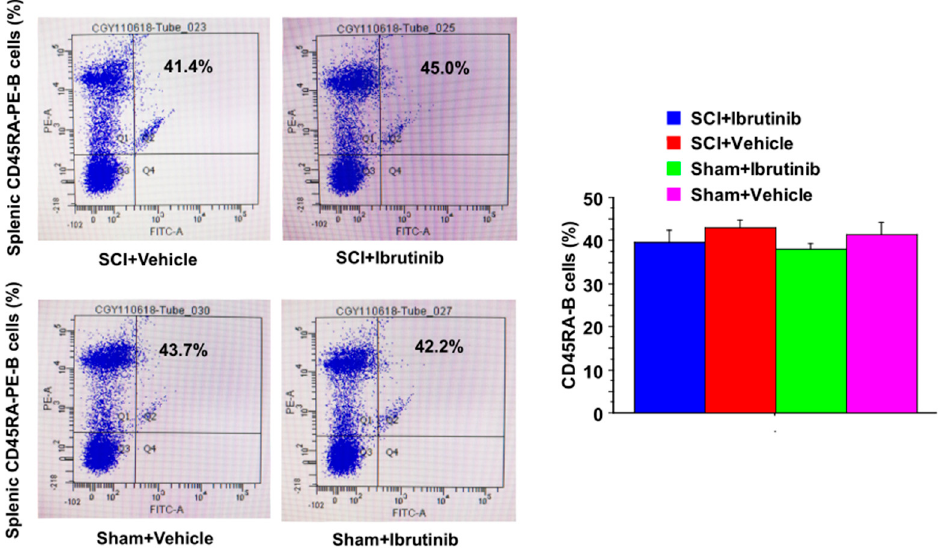
Figure 3. Ibrutinib did not reduce CD45RA-positive B cell population after SCI Injury. Flow cytometry analysis of splenic samples showed that there were no differences in CD45RA-positive B cell population between Ibrutinib-treated and vehicle-treated injured or sham-operated animals at 1-week post-injury. Anti-CD45RA-PE antibody was specific for the rat CD45RA-B cells. Data are presented as mean ±S.E.M., n = 4 per group, and analyzed with one-way ANOVA followed by Bonferroni post hoc analysis.